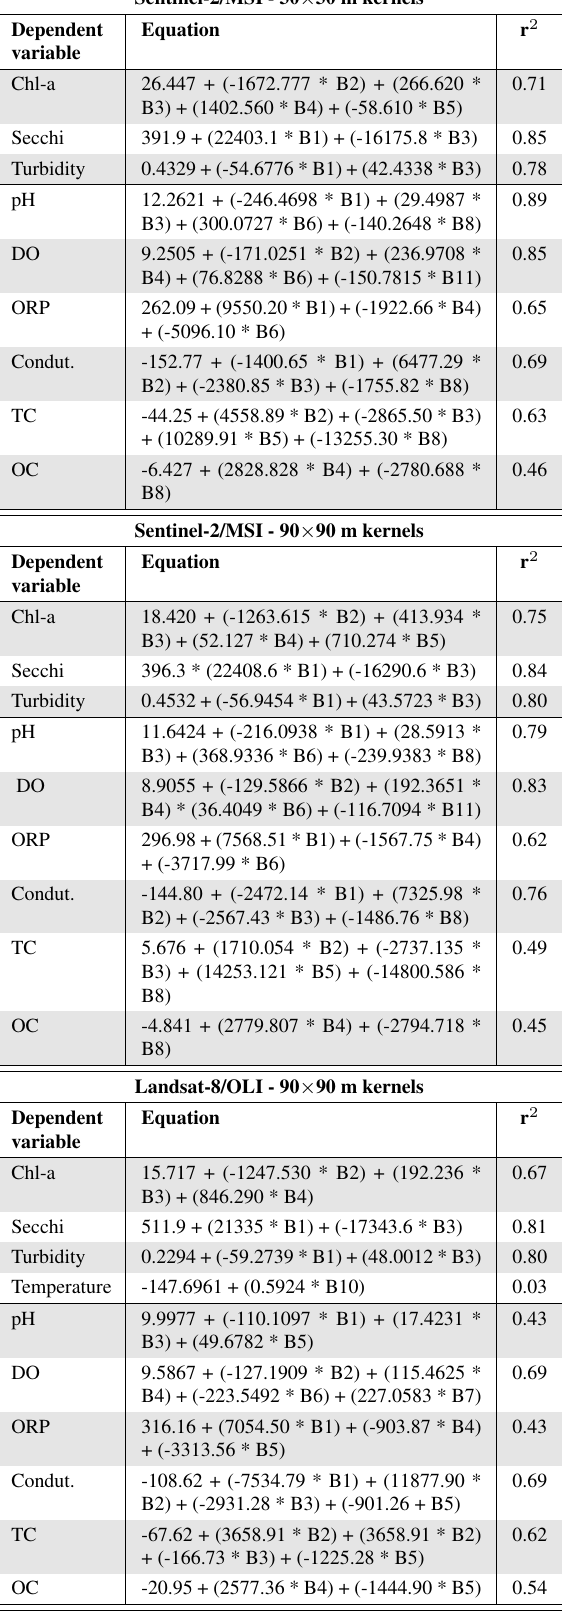
Table 5. Regression equations for the water quality models for the Sentinel-2 using 30x30 kernels (top), 90x90 kernels (middle) and Landsat-8 using 90x90 kernels